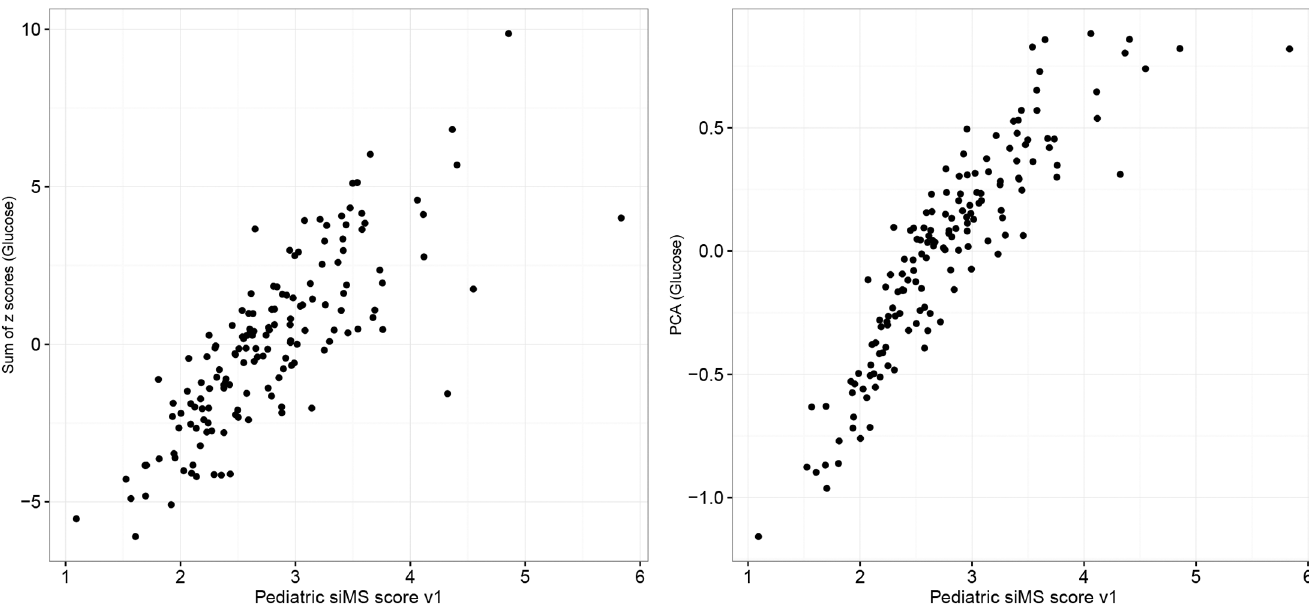
Fig 1. Correlation of pediatric siMS score variant 1 (PsiMS v1) with continuous MS scores calculated using sum of Z scores (with glucose as one of the five factors) and PCA analysis (with glucose as one of the five factors) * . * Sum of z scores (Glucose)–sum of z scores with glucoseas one of the five components; PCA (Glucose)–Principal componentanalysiswith glucoseas one of five variables.